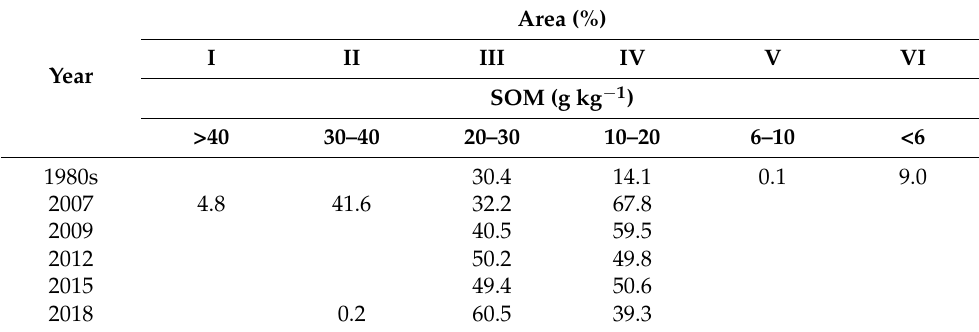
Figure 5. Spatial distribution map of soil organic matter (SOM) content in the 1980s in Lishu County. Table 5. The statistical results of soil organic matter (SOM) content for different categories at different times.